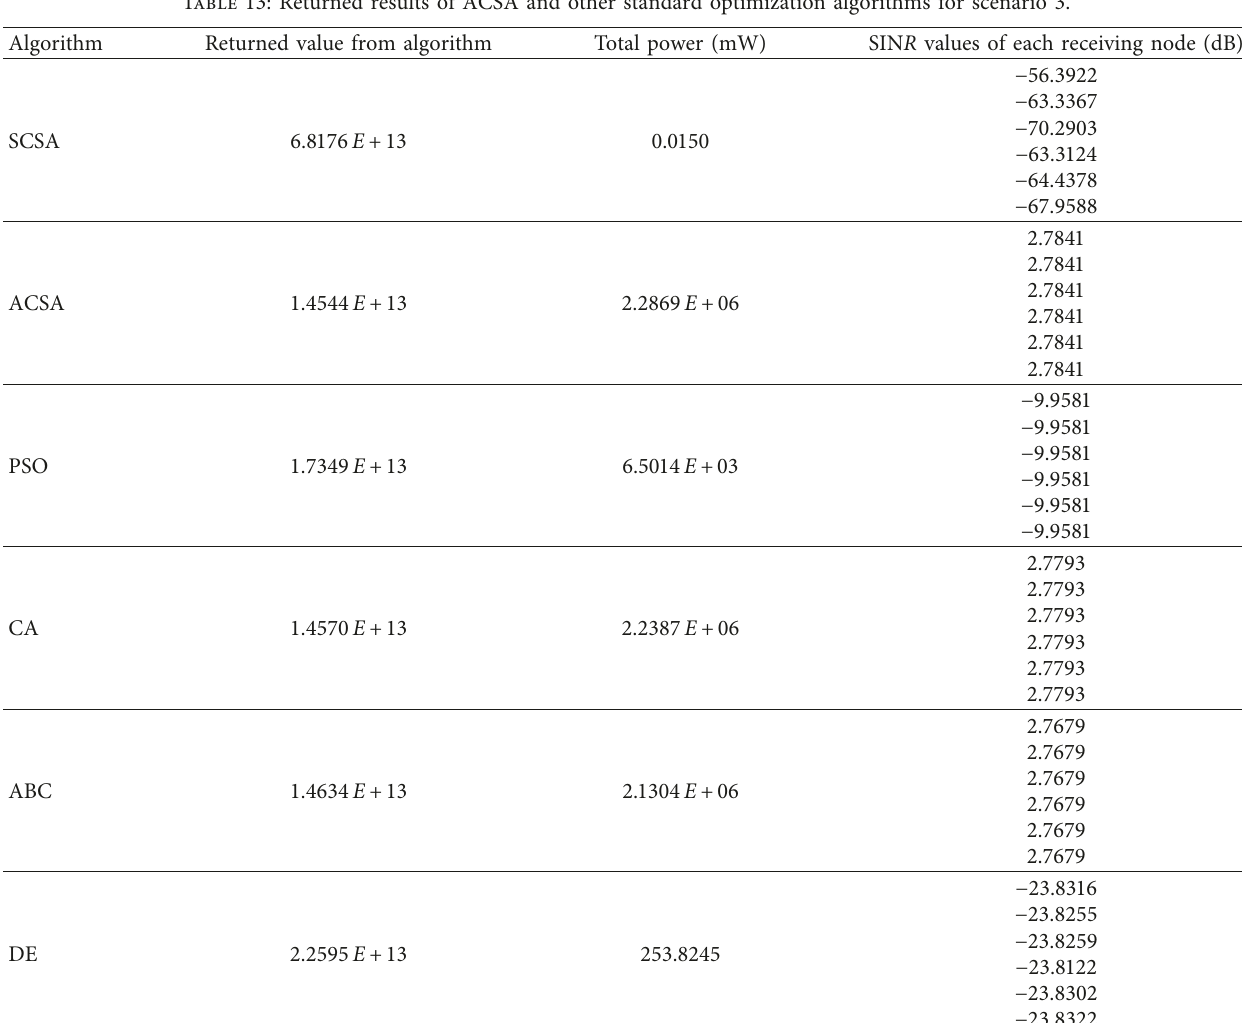
Table 13: Returned results of ACSA and other standard optimization algorithms for scenario